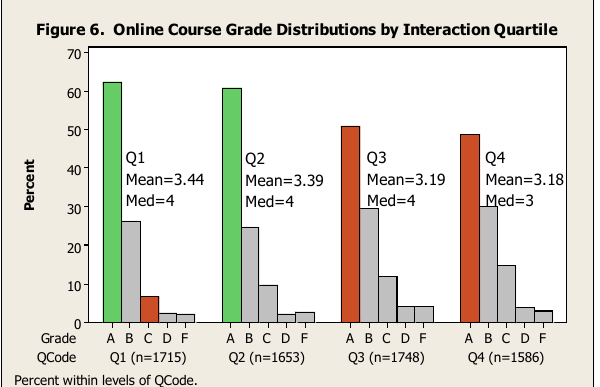
Figure 6 . Online course grade distributions by interaction